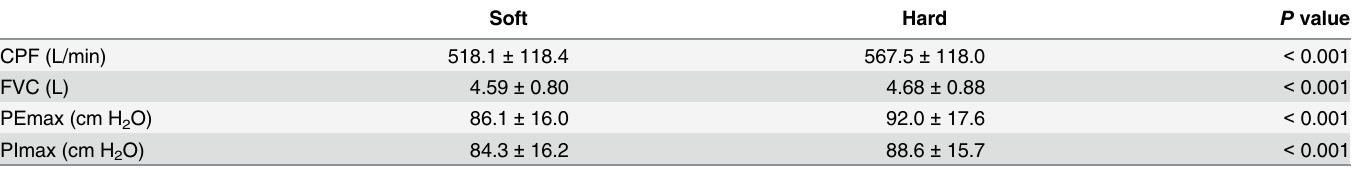
Table 1. Cough parameters measured at two different pressure relieving air-mattress firmness